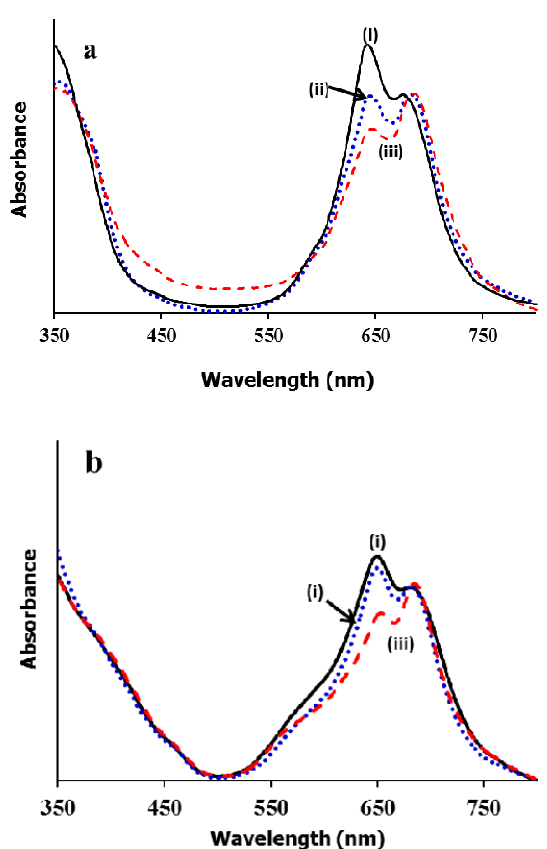
Figure 2. (a) Electronic absorption spectra of (a) 7 and (b) 6 in aqueous solution at three different